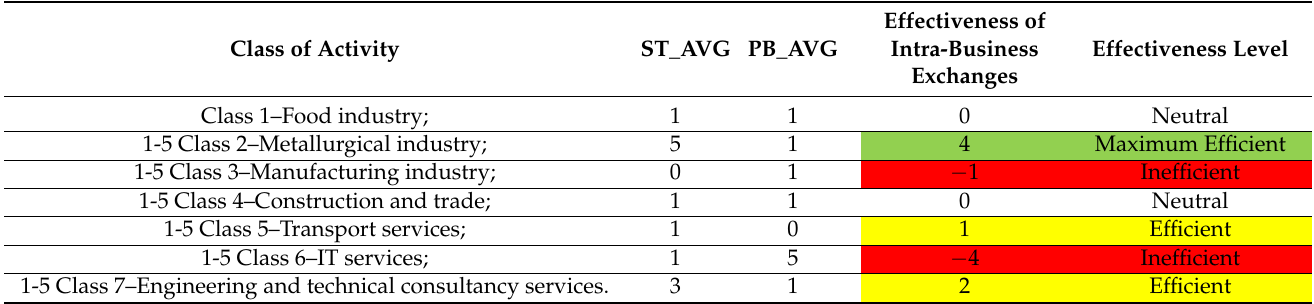
Table 4. Assessing the effectiveness of intra-business exchanges on sales markets by classes of activity.